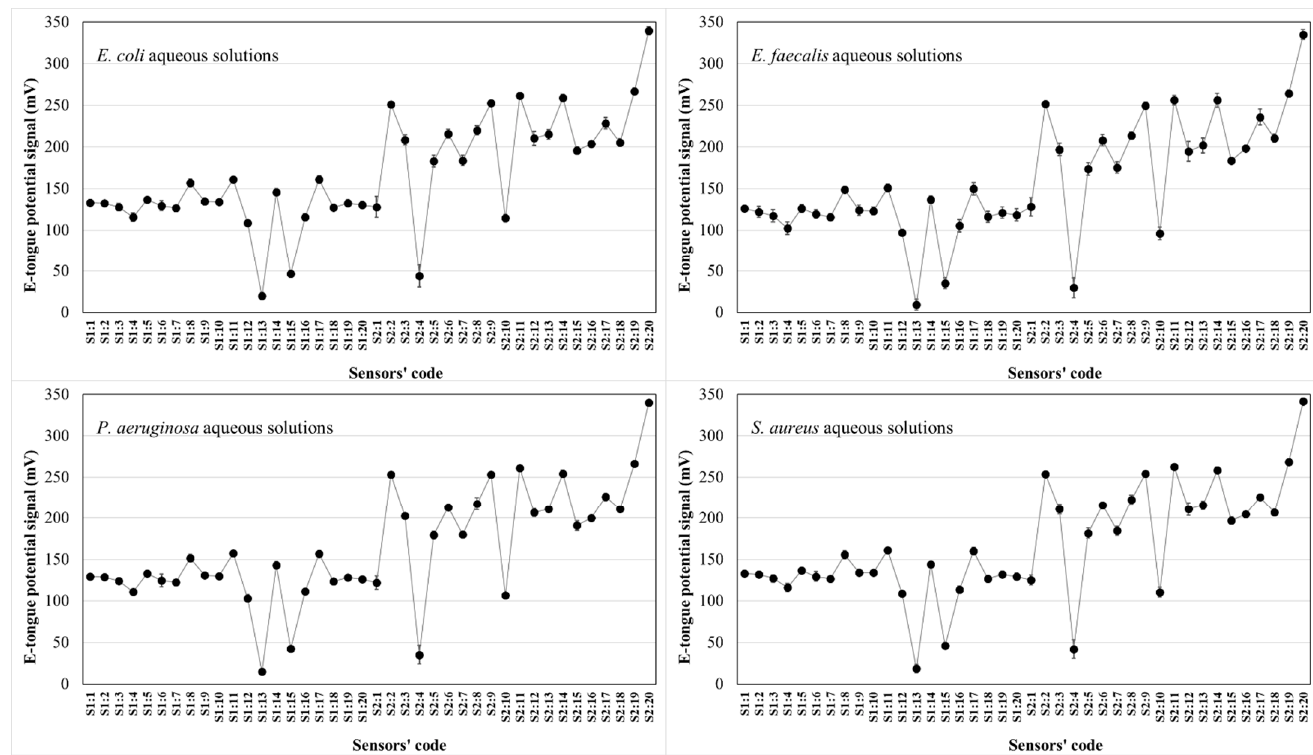
Figure 2. E-tongue potentiometric signal profiles recorded during the analysis of aqueous 0.1 mol/L HC1 solution containing each of the four microorganisms indicated in the plot.